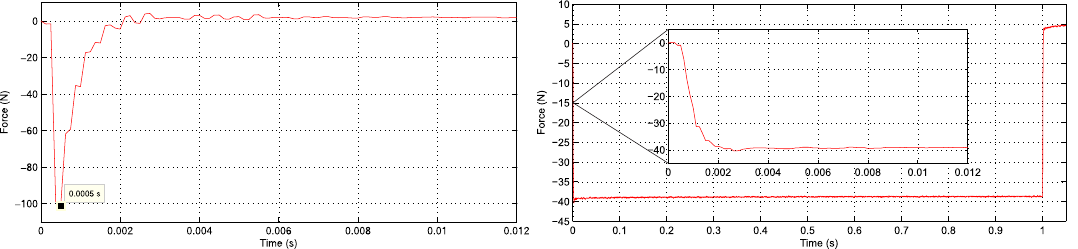
Figure 4. Impulse and step response of JR3 sensor without